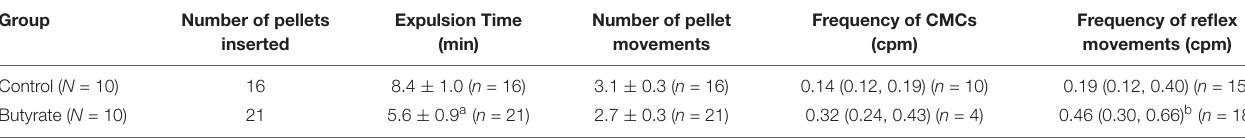
TABLE 5 | Frequencies of motor patterns in the control and butyrate groups. Group Number of pellets